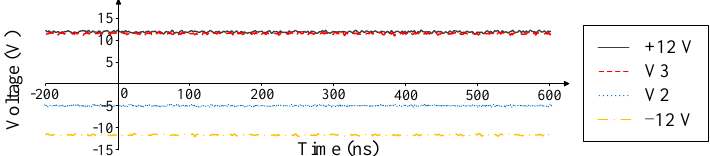
Figure 11. Waveform between the V2, V3, and ± 12 V levels and analog ground (AGND) under the working conditions of the capture card.